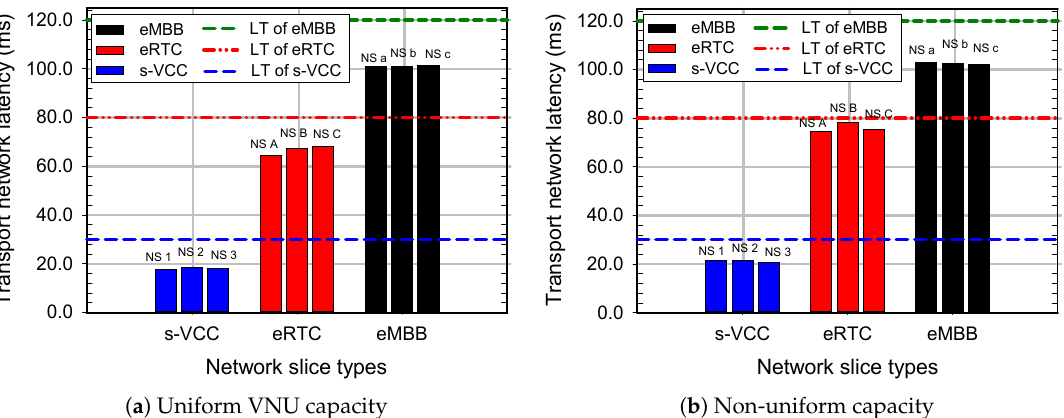
Figure 4. Transport network latency for different network slices when the VNU capacity of DCs is uniform and